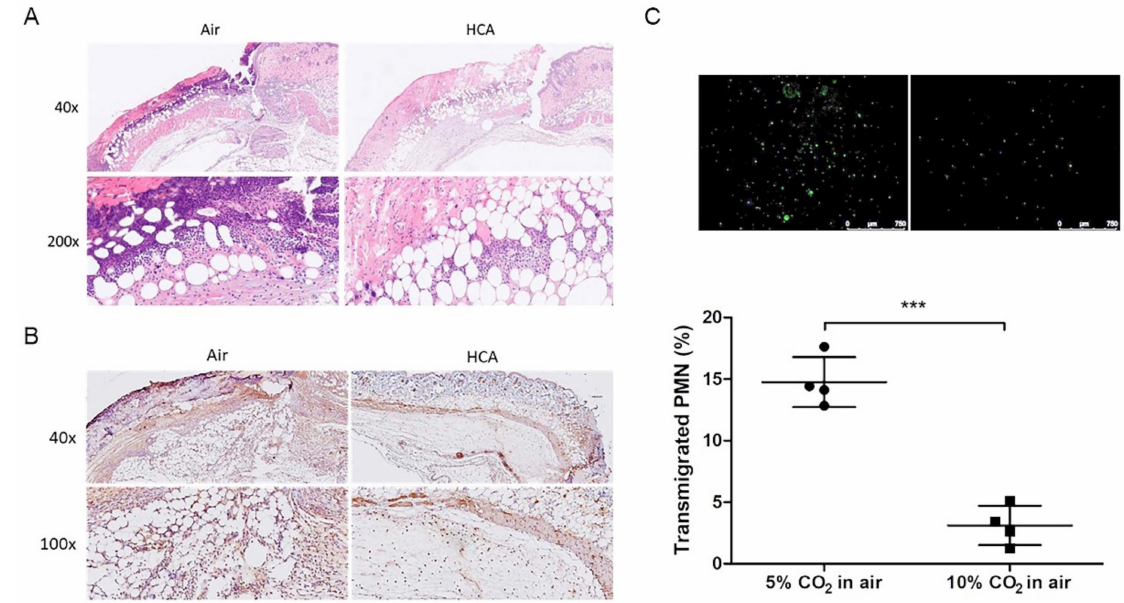
Figure 9. Effects of HCA on neutrophil recruitment in mice. ( A ) Histological appearance of skin grafts on day 3 after transplantation was shown by a representative micrograph (40 × and 200 × magnification). ( B ) The immunohistochemical staining (200 × magnification) of Ly6G expression in the grafts. ( C ) A neutrophil migration assay was performed by the MIP-2 (1 µ g/mL) chemoattractant. Migrated neutrophils were stained (green) and evaluated by fluorescence microscopy (10 × ; white bar = 750 µ m). Error bars represent the SD from four independent experiments; *** p <